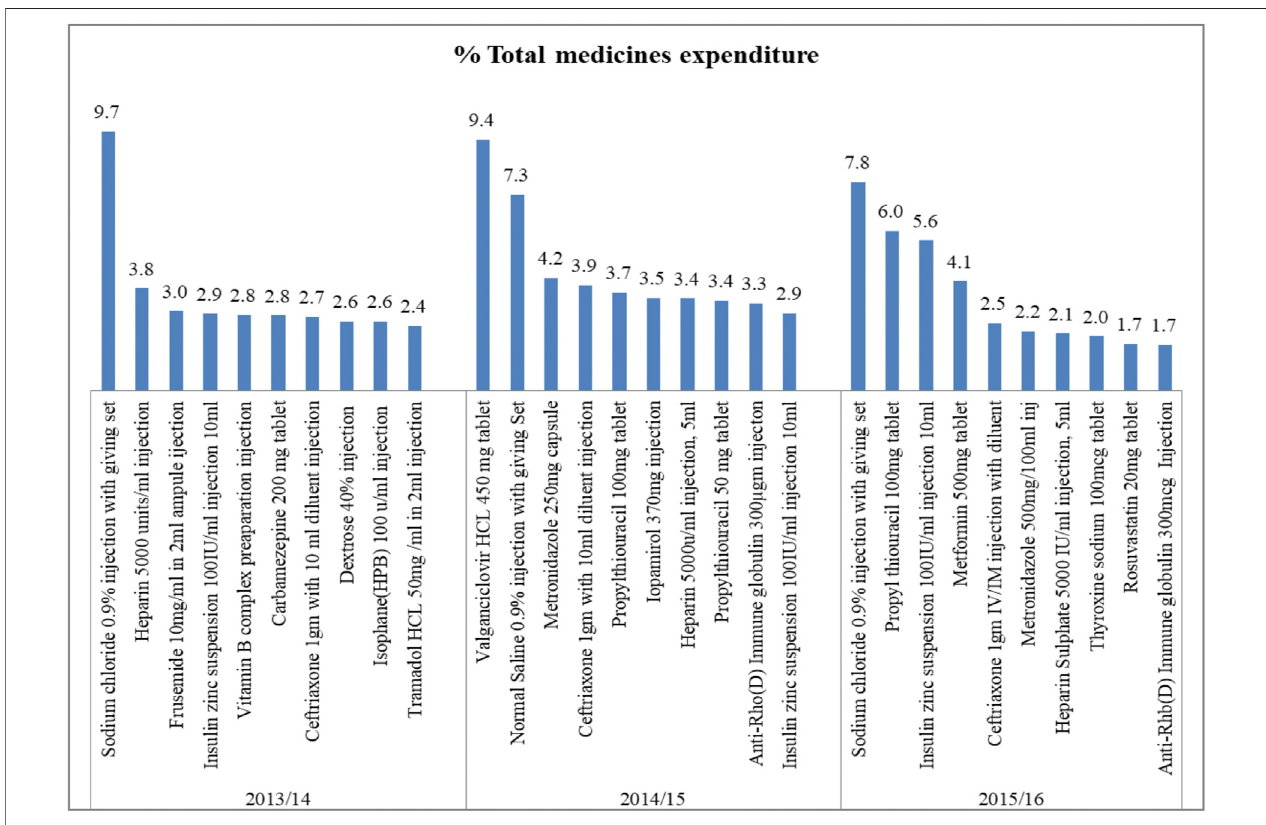
FIGURE 2 | Top ten (based on cost) class “ A ” medicines in SPHMMC (2013/14 – 2015/16), March 2017.